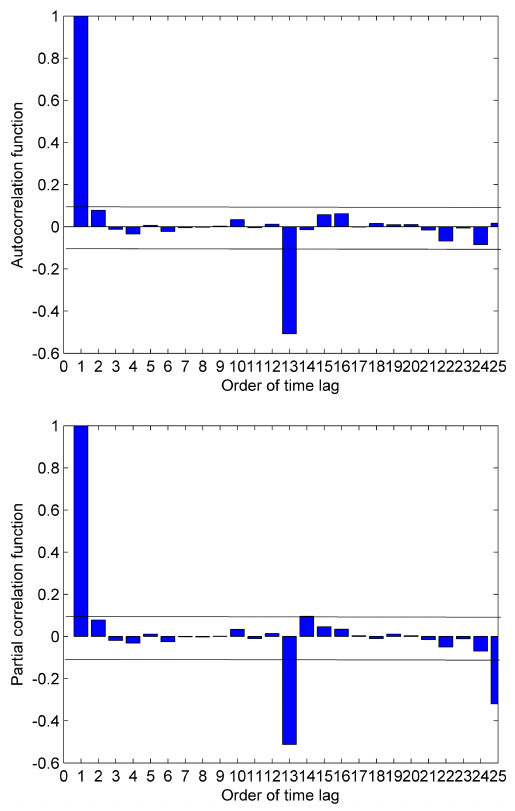
Figure 4. Autocorrelation and partial correlation plots of data se- ries. Upper panel: autocorrelation; lower panel: partial correlation.